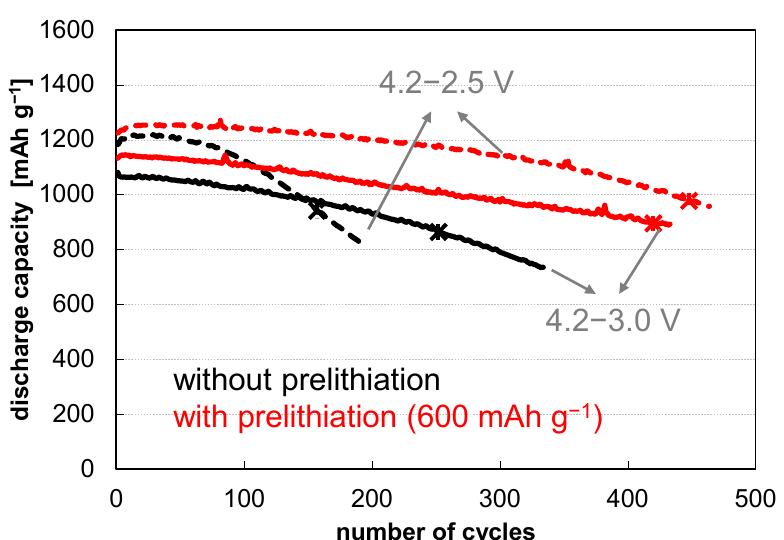
Figure 9. Cycling behavior of full cells (discharge capacity of anode active material) with prelithiated anodes based on standard CLM00001 with the optimal prelithiation level of 600 mAh g − 1 in two different voltage windows. The asterisks mark 80% capacity retention. The cycle life for the 4.2–2.5 V range (dotted line) is slightly better than for the 4.2–3.0 V range (solid line). More than 440 cycles are possible in this configuration without carbon coating or classification.